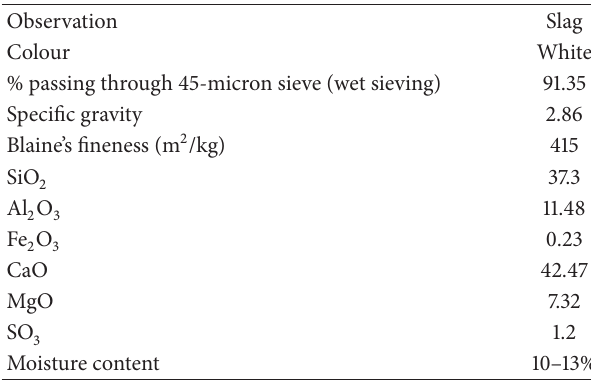
Table 1: Physical and chemical properties of slag.